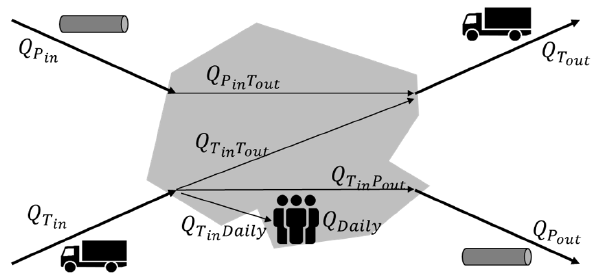
Figure 5. Composition of the required tank